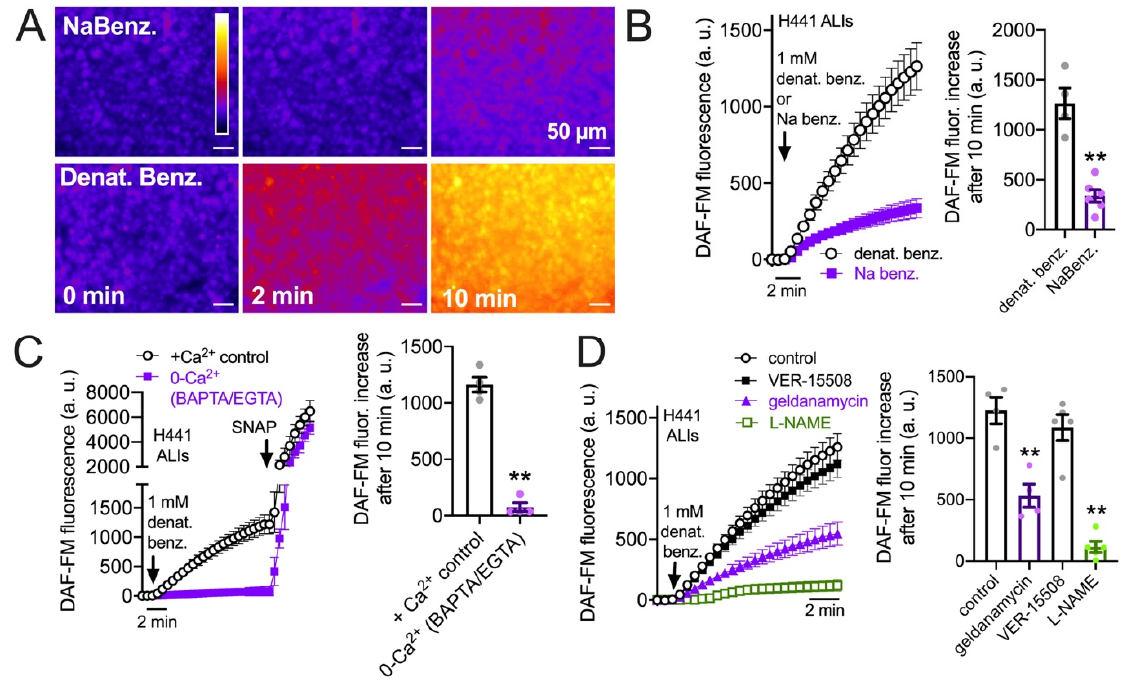
Figure 1. HSP90 inhibition reduces T2R-stimulated intracellular NO production in H441 cells grown at the air–liquid interface (ALI). ( A ) : Representative image of DAF-FM-loaded H441 ALIs stimu- lated for 10 min with 1 mM sodium benzoate (NaBenz.) or denatonium benzoate (denat benz.); fluorescence increased with denatonium benzoate but not sodium benzoate. ( B ) : Average trace and bar graph (mean ± SEM) of four experiments as in ( A ). Significance determined by Student’s t -test; ** p < 0.01. ( C ) : Average trace and bar graph (mean ± SEM of three experiments) showing response in cultures pre-loaded with BAPTA-AM and stimulated in the absence of extracellular Ca 2+ (0-Ca 2+ o ) vs. control cultures pre-incubated with 0.1% DMSO only and stimulated in the presence of extracellular Ca 2+ . ( D ) : Denatonium-induced DAF-FM fluorescence increases in H441 ALIs were inhibited by pretreatment with geldanamycin or L-NAME but not HSP70 inhibitor VER-15508. Average trace and bar graph of results from four independent experiments are shown. Significance determined by one-way ANOVA with Dunnett’s post-test comparing all values to control (denatonium only); ** p < 0.01.